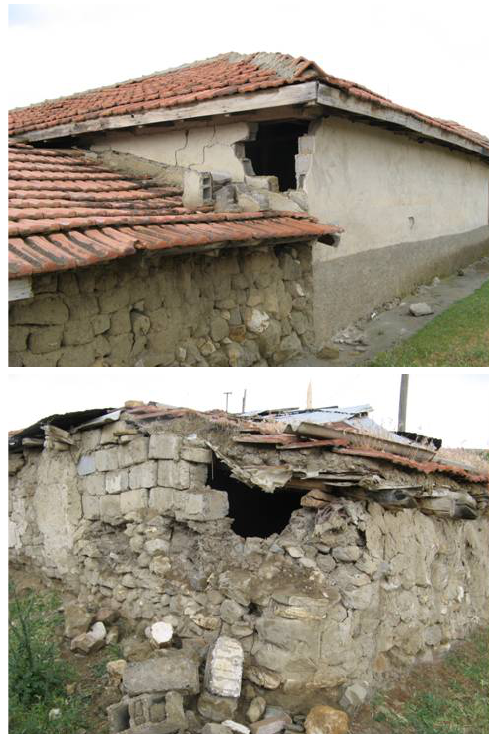
Fig. 10. Examples of failure of masonry building corners. Fig. 10 Examples of failure of masonry building corners